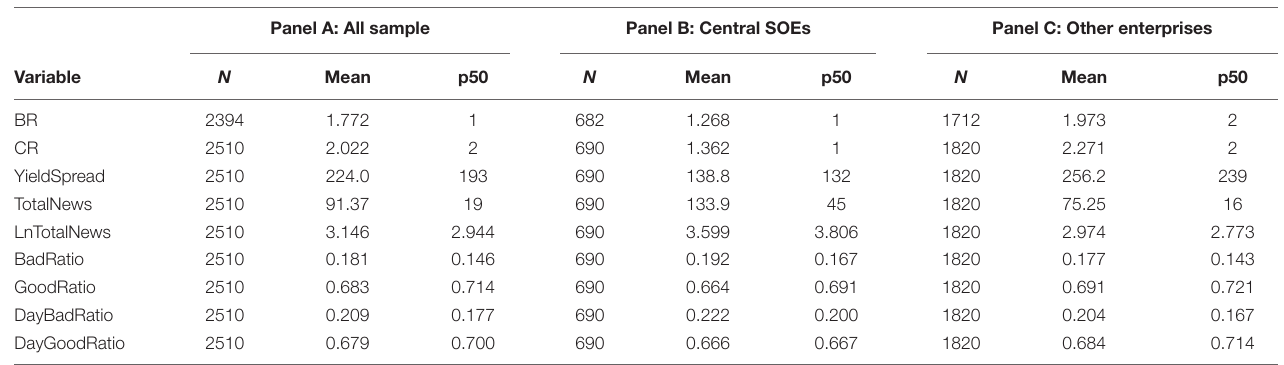
TABLE 2 | Descriptive statistics of the internet news about China’s listed enterprises from 2010 to 2020. Panel A: All sample Panel B: Central SOEs Panel C: Other enterprises